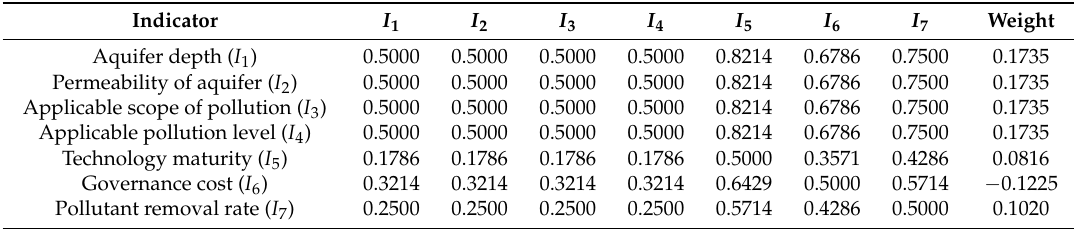
Table 4. Fuzzy consistent judgment matrix and weight list of evaluation